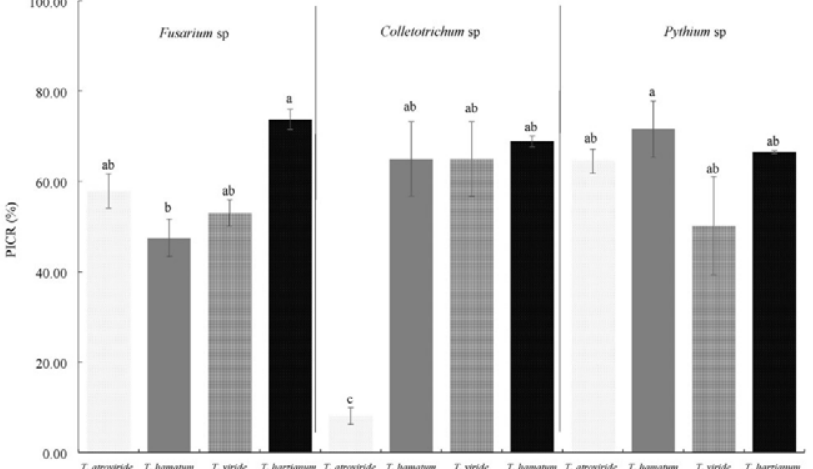
Fig. 3. Percentage of inhibition (PICR) of Trichoderma strains on phytopathogenic fungi of the Nopal vegetable culture in vitro . * Different letters mean significant difference between treatments according to Tukey